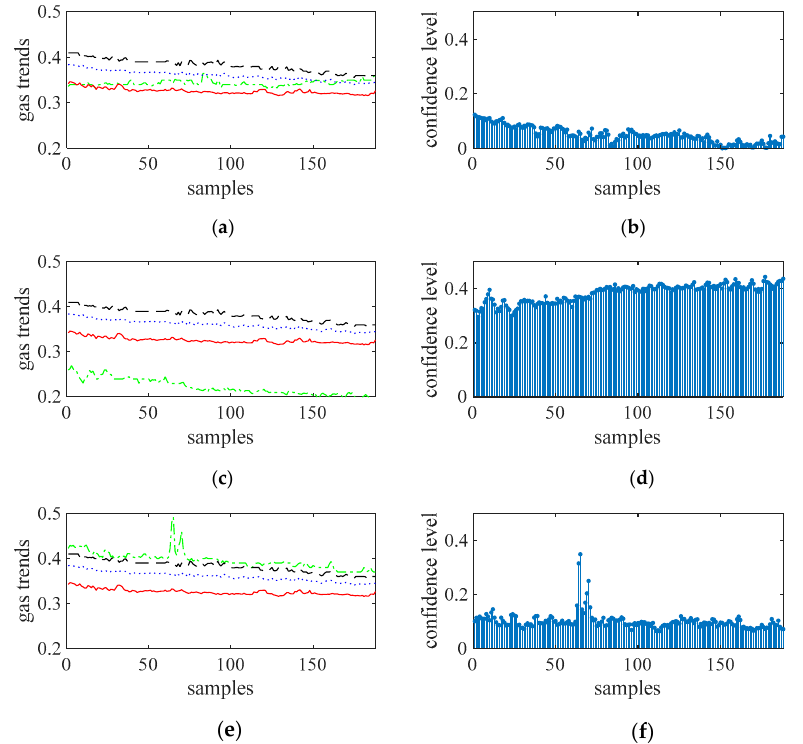
Figure 9. The measured values of sensors 4 to 6 and their confidence level. ( a ) gas sensor 4, ( b ) confidence level of gas sensor 4, ( c ) gas sensor 5, ( d ) confidence level of gas sensor 5, ( e ) gas sensor 6, ( f ) confidence level of gas sensor 6.